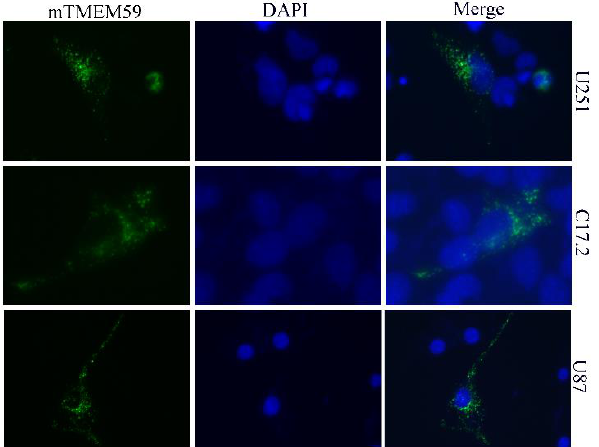
Figure 2. Intracellular localization of the mouse TMEM59 (mTMEM59) in different cells. U251, C17.2, and U87 cells were transiently transfected with pEGFP-N2 – mTMEM59, and similar to hTMEM59L, mTMEM59 also localized to vesicular structures in the cytoplasm and to the perinuclear region. DAPI represents cells and reflects the intracellular location of TMEM59.